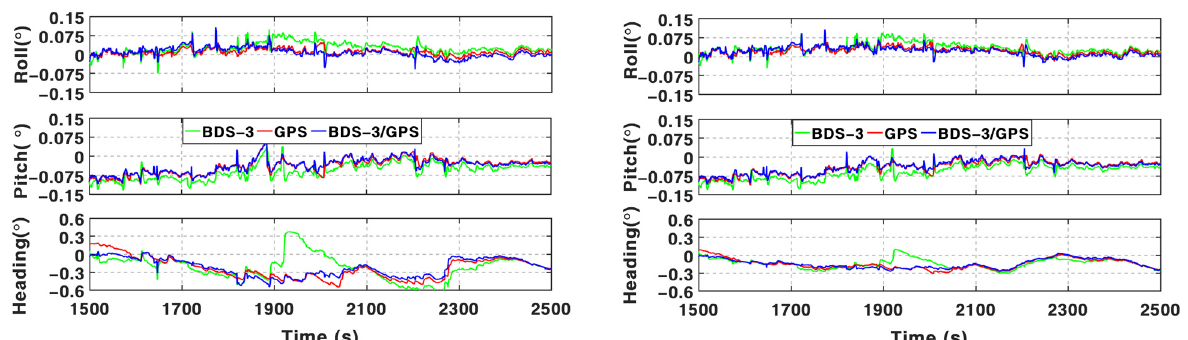
Figure 20. Attitude errors of BSSD PPP/INS TCI ( left ) and BSSD PPP/INS/ODO TCI ( right ) with frequent GNSS outages in the periods between the 1500 s and 2500 s.